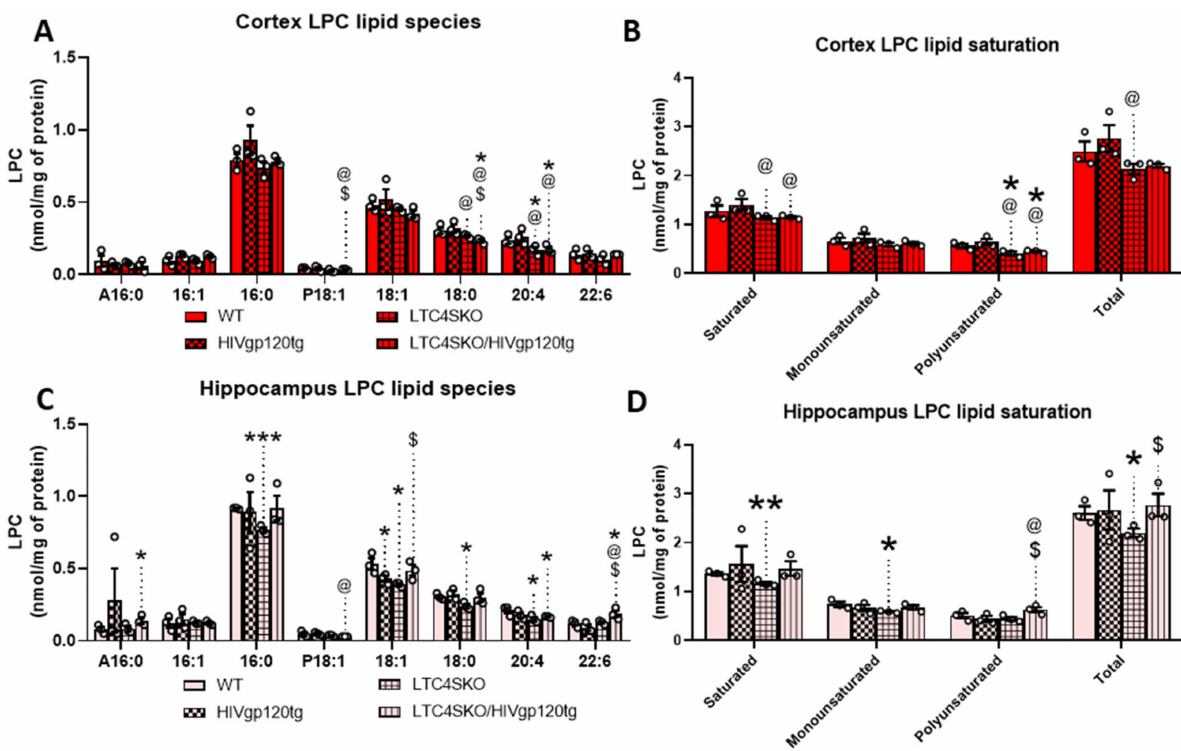
Figure 5. Lysophosphatidylcholine (LPC) lipid species levels show differential fatty acid composi- tion in the cortex and hippocampus of female mice as a result of LTC4S knockout. Analysis of the subspecies within the LPC lipid class of the lipid extracts from both cortex ( A , B ) and hippocam- pus ( C , D ) were quantified by MDMS-SL. Individual LPC species with masses above 0.05 nm/mg were graphed for cortex ( A ) and hippocampus ( C ). Total masses of saturated, monounsaturated, polyunsaturated, and total LPCs with masses above 0.05 nm/mg were quantified and plotted for cortex ( B ) and hippocampus ( D ). Bar graphs displaying cortical lipids (red) and hippocampal lipids (pink) are shown separated by a dashed line. Values in graphs are mean ± s.e.m.; n = 3, female, 6 months of age. Individual data points are represented in the graphs by an symbol. ANOVA (cid:35) followed by Fisher’s PLSD post hoc test for cortex lipids and hippocampus lipids were independently analyzed for each fatty acid subspecies—while graphs shown above are reflected on a single x axis to illustrate intraspecies differences. The p -value level of significance is as follows: * p ≤ 0.05, ** p ≤ 0.01, *** p ≤ 0.001, @ p ≤ 0.05, $ p ≤ 0.05—while p -value significance correlations are symbolized as follows: * indicates significances from the WT, @ indicates significances from HIVgp120tg, and $ indicates significances from LTC4SKO